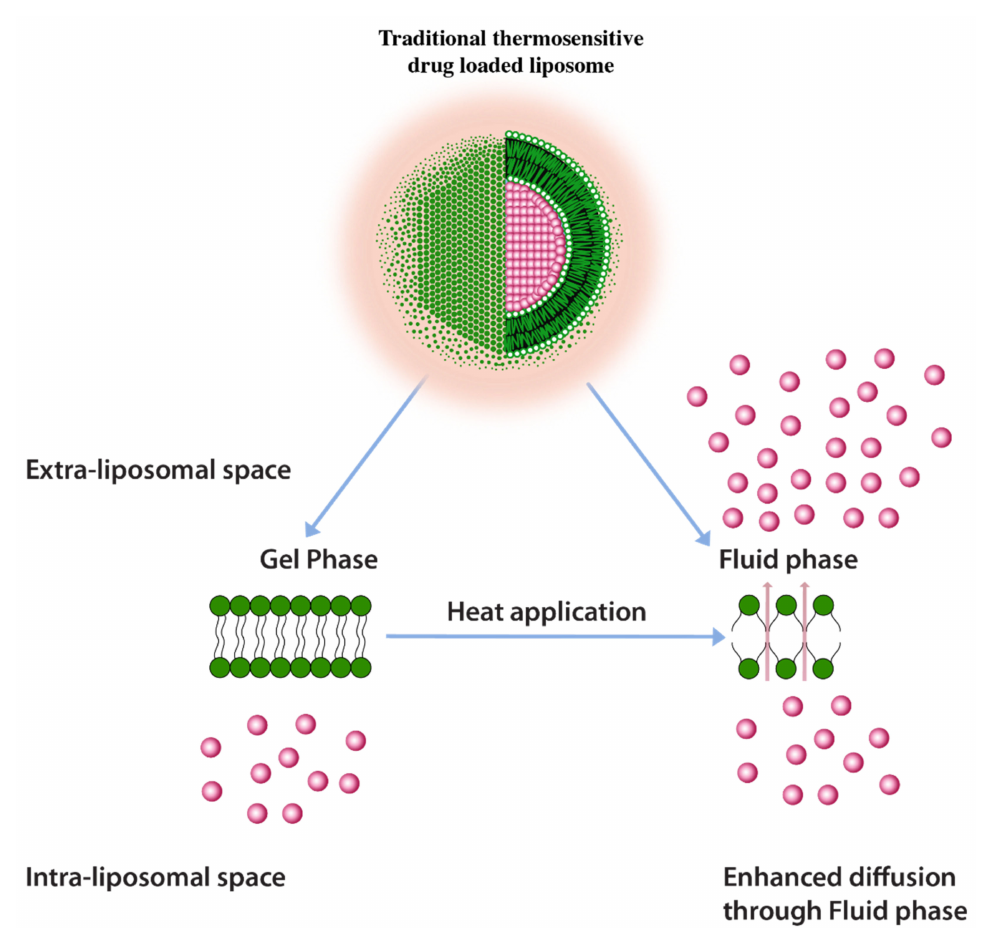
Figure 9. Traditional thermosensitive liposomes showing gel to fluid phase transition upon application of heat.